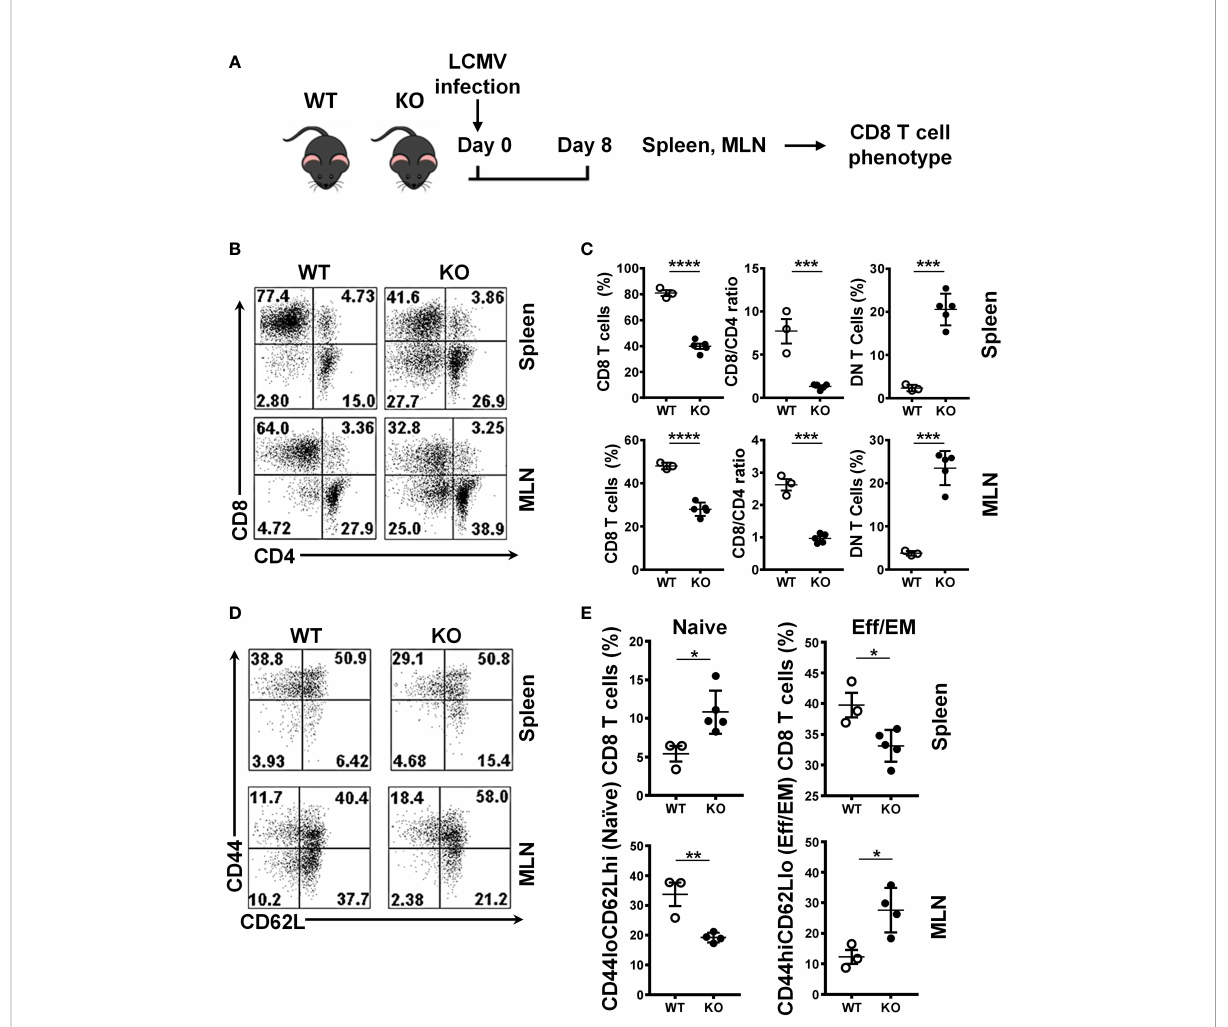
FIGURE 3 Impaired expansion of Srsf1-cKO CD8 T cells during the immune response to viral infection. (A) Schematic presentation of LCMV infection protocol. Srsf1 -cKO (KO) or WT mice were infected with LCMV Armstrong strain by IP injection. After 8 days of infection, spleen and mesenteric lymph nodes (MLN) were collected for T cell phenotyping (B) Plots show the frequency of CD8, CD4 and CD4-CD8- double negative (DN) T cells gated on live Thy1.2+ T cells. (C) Graphs show the percentages of CD8 T cells, CD8/CD4 ratio and DN in the spleen and MLN of WT (n=3) and KO (n=5) mice. (D) Plots show the CD44 and CD62L staining of spleen and MLN cells gated on live CD8 T cells. (E) Graphs show the percentages CD44loCD62Lhi (naive) and CD44hiCD62Llo (effector) CD8 T cells from WT (n=3) and KO (n=5) mice. Graphs show mean ±